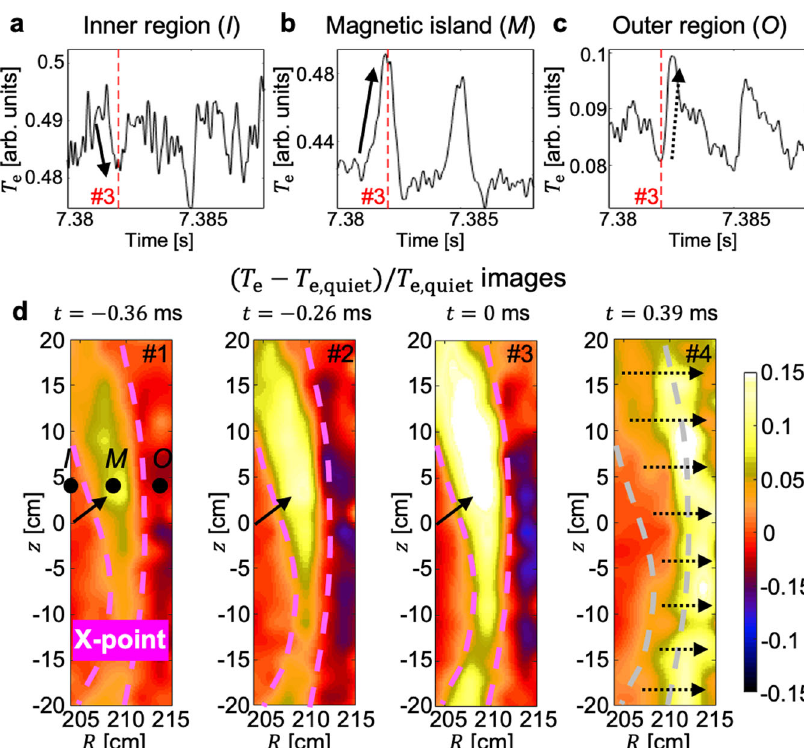
Fig. 3 Spontaneous T e peaking inside a magnetic island. a – c , T e measurements in time at positions I , M, and O (marked in the #1 image in d ), respectively. d The 2D relative change of T e around the magnetic island during a single turbulence spreading event. Absolute time of #3 is indicated by a red dashed line in ( a – c ).